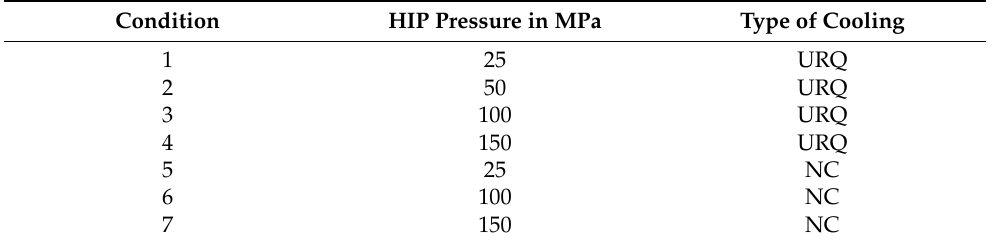
Table 2. Parameter sets of HIP heat treatment. A constant heating rate of 15K/min, a dwell time of 30 min and an austenitizing temperature of 1050 ◦ C were applied, followed by natural cooling or quenching. Condition HIP Pressure in MPa Type of Cooling 25 URQ